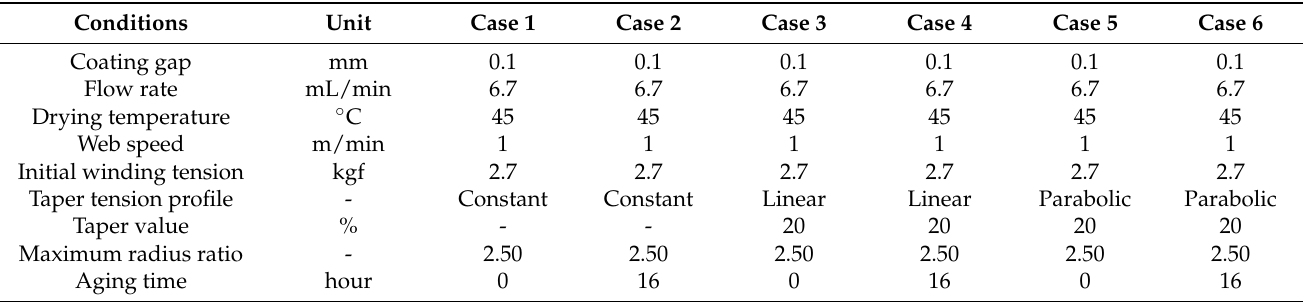
Table 2. Coating and winding process conditions for cases